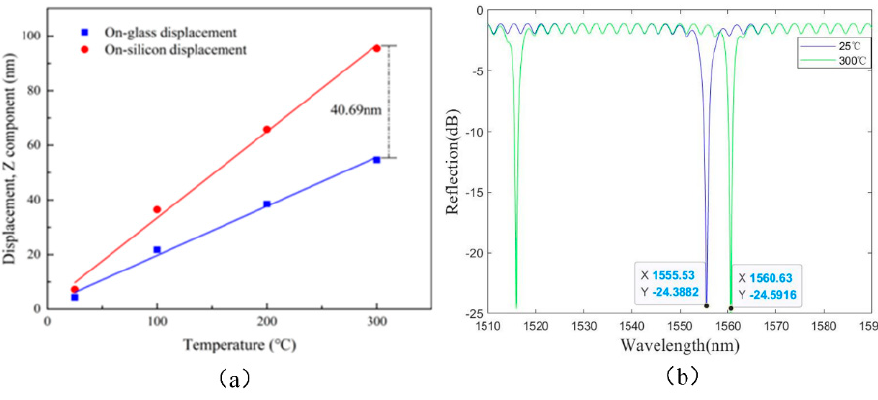
Figure 3. The thermal simulation results of the Fabry–Perot cavity: ( a ) the thermal expansion of the Fabry–Perot cavity, and ( b ) the peak shift of the interference spectrum of the Fabry–Perot cavity.